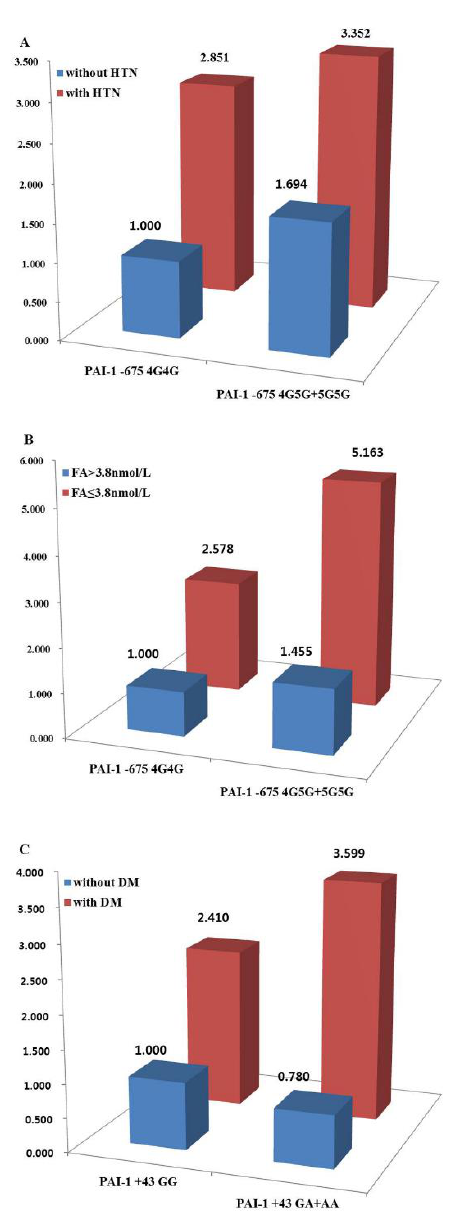
Figure 1. Colorectal cancer incidence (odds ratio) by interactions between genes and environmental factors such as ( A ) hypertension (HTN), ( B ) folate (FA), and ( C ) diabetes mellitus (DM).